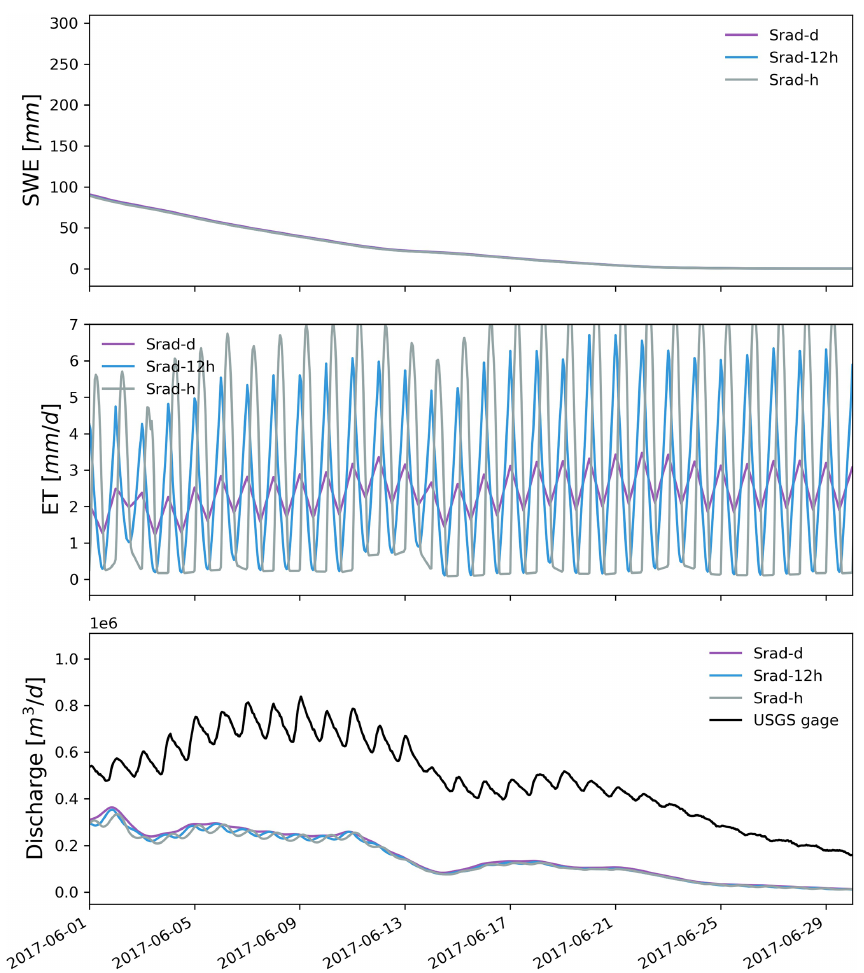
Figure A7. Zoomed-in plots showing simulated SWE, ET, and watershed outlet discharge under different temporal resolutions of S rad .